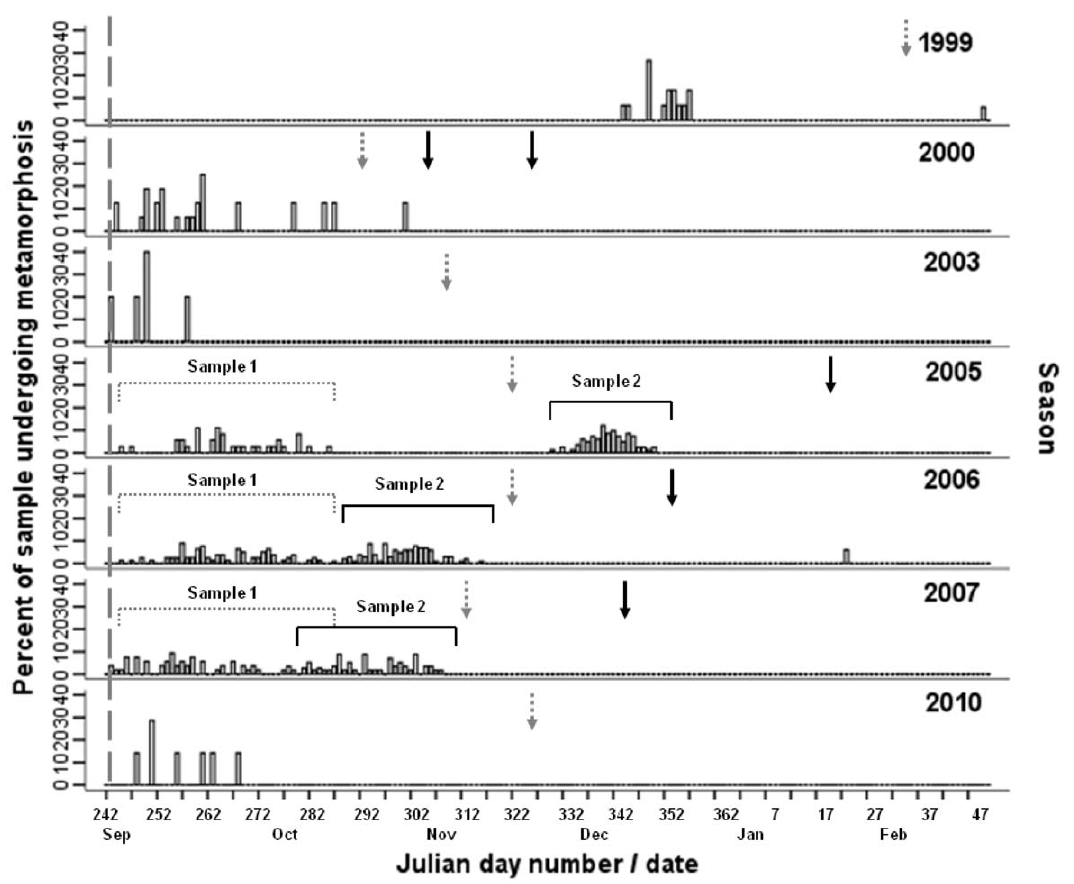
Figure 5. Percent frequency of Chironexfleckeri medusae that metamorphosed each day. Frequency is percentage within a sample and date is Julian day number or month, with 30 August referenced by a grey dash line. The first sampling occasion within a season is denoated by a grey arrowhead line, while subsequent sampling occasion(s) are denoted by a black arrowhead line.